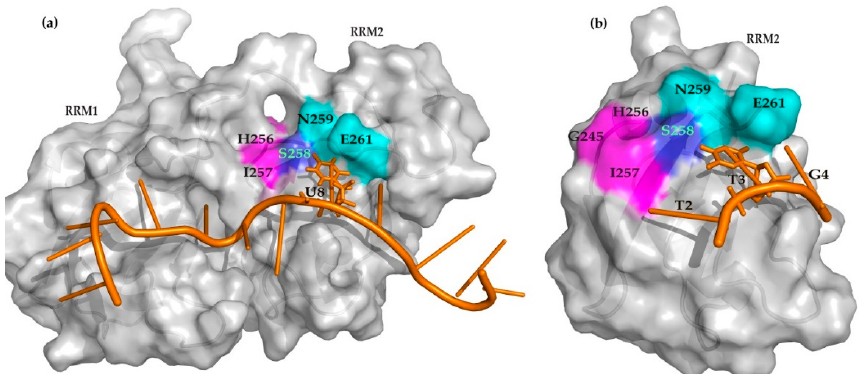
Figure 5. Comparison of binding sites of nucleic acids and hits on TDP-43. ( a ) Surface representation of TDP-43 tandem RRMs in complex with AUG12 RNA (orange cartoon), where residues interact with the U 8 nucleotide (stick) and hits are highlighted in cyan and magenta, respectively. Residue S258 (blue) interacts with both U 8 and hit 1. ( b ) Surface representation of TDP-43 RRM2 in complex with ssDNA (PDB code: 3D2W) using the same coloring scheme.